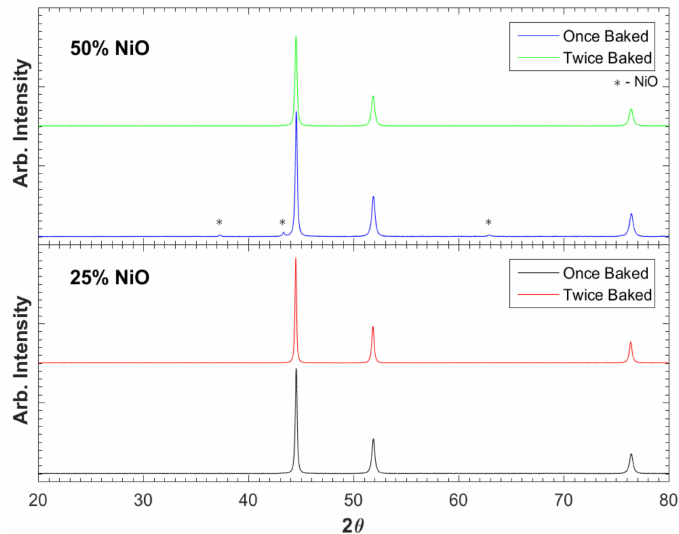
Figure 4. XRD of once baked and twice baked specimens of both 25% NiO and 50% NiO loadings. Unmarked peaks are Ni metal. There is very small oxide component remaining for the 50% NiO sample after the first bake. It is not found in any other